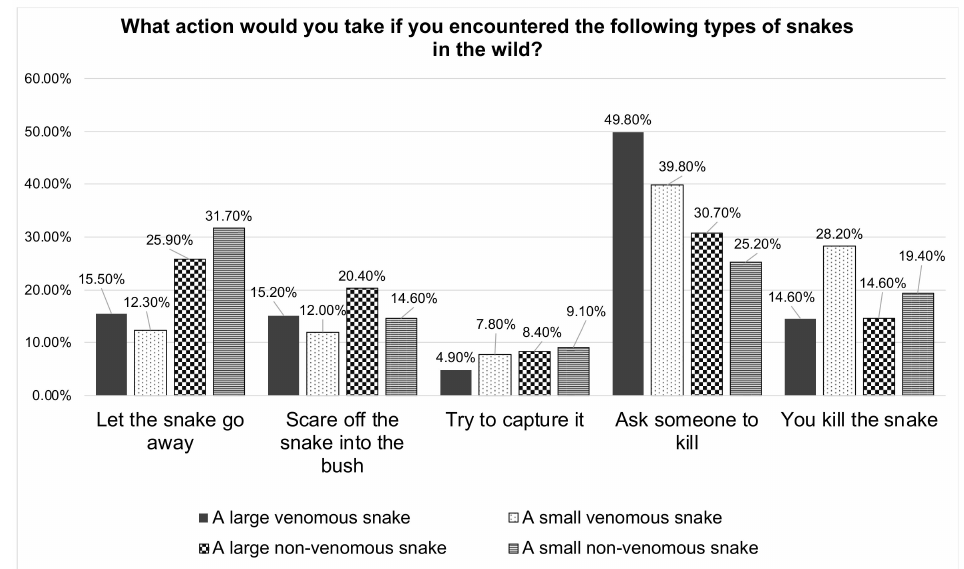
Figure 2. Participants’ perceptions towards encountering different types of snakes in the